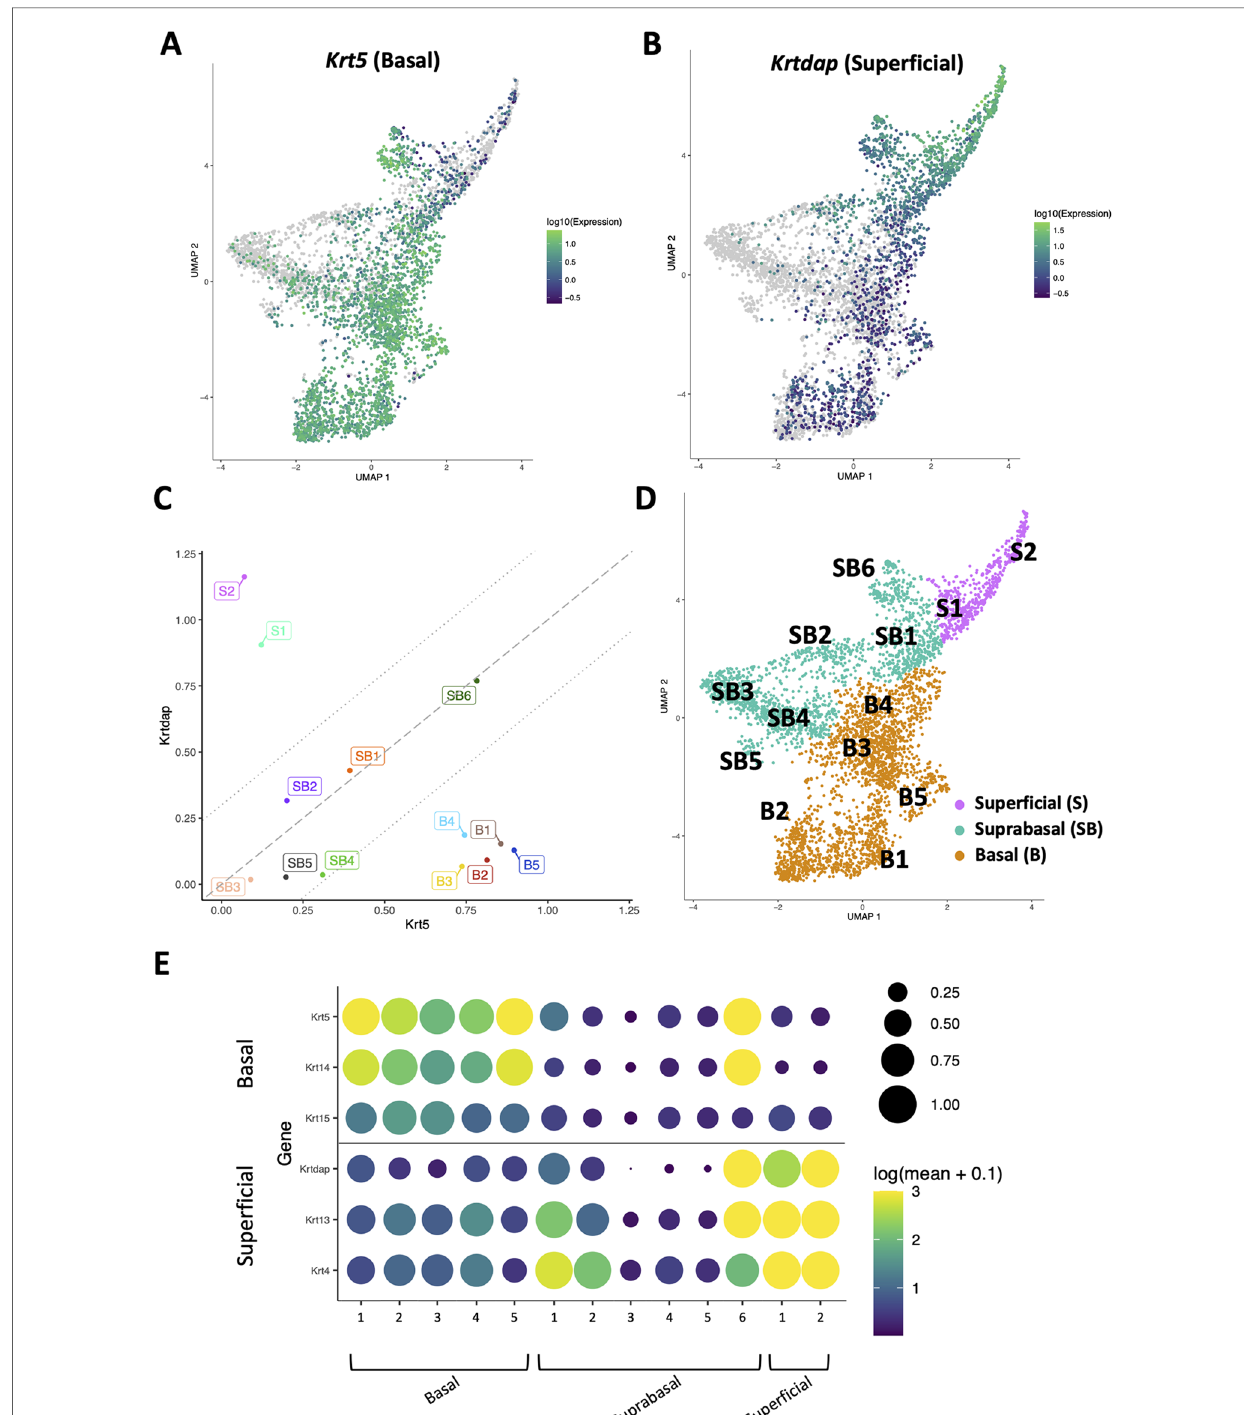
FIGURE 2 Identi fi cation of basal, suprabasal, and super fi cial cells across dataset. ( A,B ) Normalized log 10 expression gradients of Keratin 5 ( Krt5 ), an established marker of basal esophageal epithelial cells in A, or Keratinocyte Differentiation-Associated Protein ( Krtdap ), an established marker of differentiated esophageal epithelial cells in B are shown across the single cell RNA-Sequencing dataset. Green indicates enrichment while purple indicates inhibition. ( C ) Normalized log 10 expression of Krt5 vs. normalized log 10 expression of Krtdap expression was plotted for all populations identi fi ed in the single cell RNA-Sequencing dataset. Populations falling within the strip de fi ned by lines with a slope of 1 passing through points (0, − 0.3) and (0, 0.3) were de fi ne as suprabasal (SB). Populations falling below this strip were de fi ned as basal ( B ) and those above this strip were identi fi ed as super fi cial ( S ). ( D ) Basal (B; denoted in orange), suprabasal (SB; denoted in teal), and super fi cial (S; denoted in pink) clusters identi fi ed on a Uniform Manifold Approximation and Projection plot (UMAP) of the entire single cell RNA-Sequencing dataset. ( E ) Cluster-average expression z-scores of putative basal and differentiated markers are shown for each population in the single cell RNA-Sequencing dataset. Circle size re fl ects percentage of cells with non-zero expression level for indicated genes. Color intensity re fl ects average expression level across all cells within each cluster with yellow indicating enrichment and purple indicating